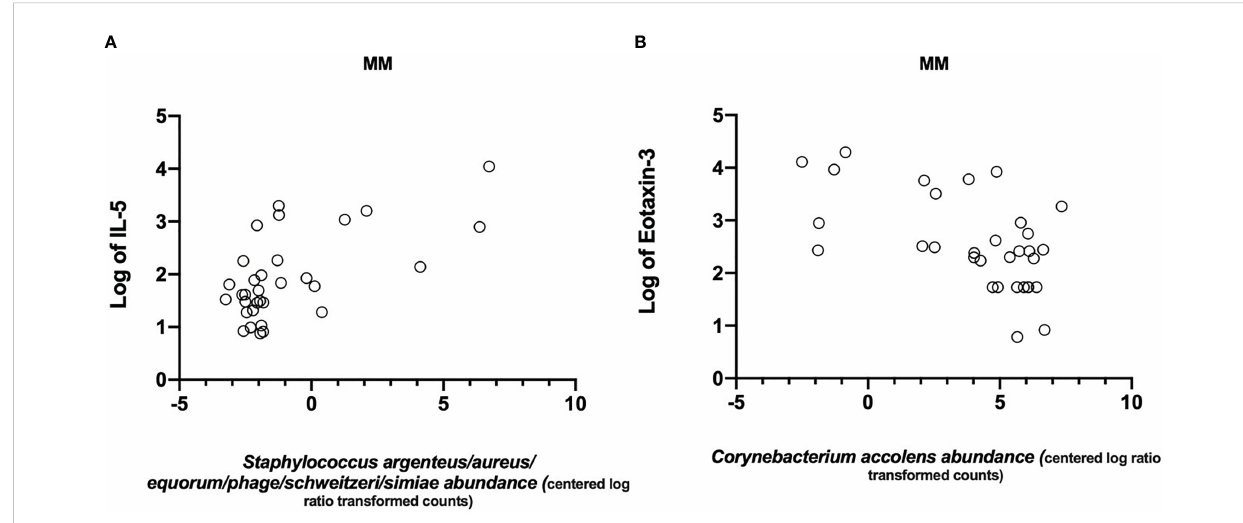
FIGURE 5 Signi fi cant correlations between mediator levels in nasal secretion and bacteria. Scatter plots showing correlations of (A) IL-5 (logtransformed) and Staphylococcus argenteus / aureus / equorum / phage / schweitzeri / simiae (Pearson r=0.55) and (B) a negative correlation between Eotaxin-3 (log- transformed) and Corynebacterium accolens (Pearson r=-0.54).